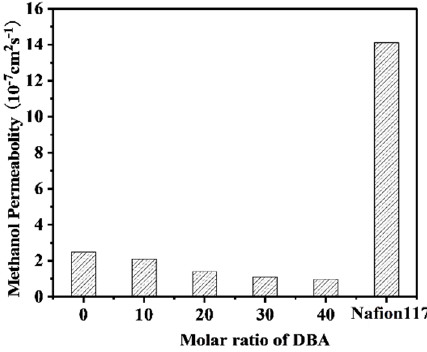
Figure 10. The methanol permeability of CSPEN-60-DBA-x at different temperatures.